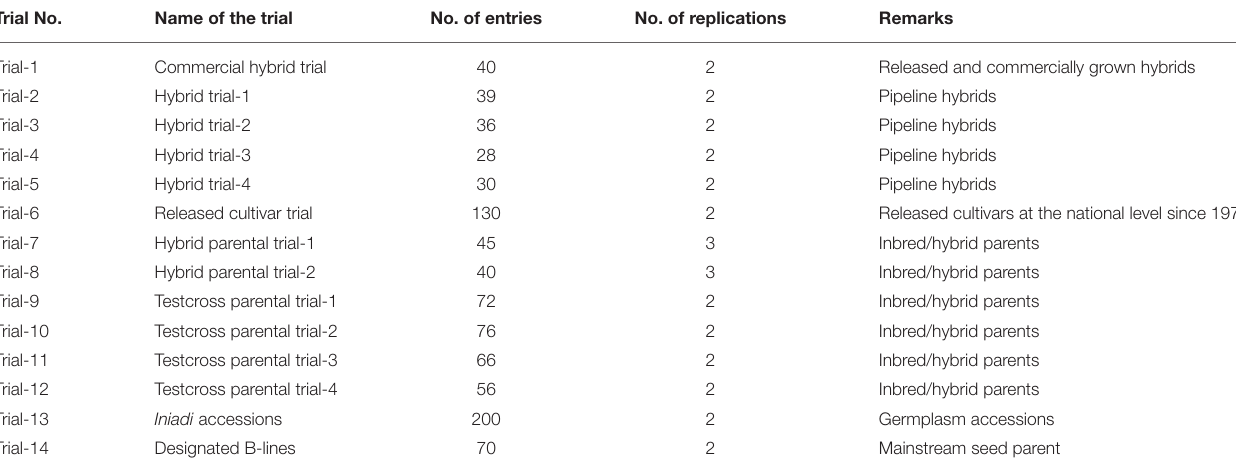
TABLE 1 | Study materials evaluated in 14 trials and remarks. Trial No.